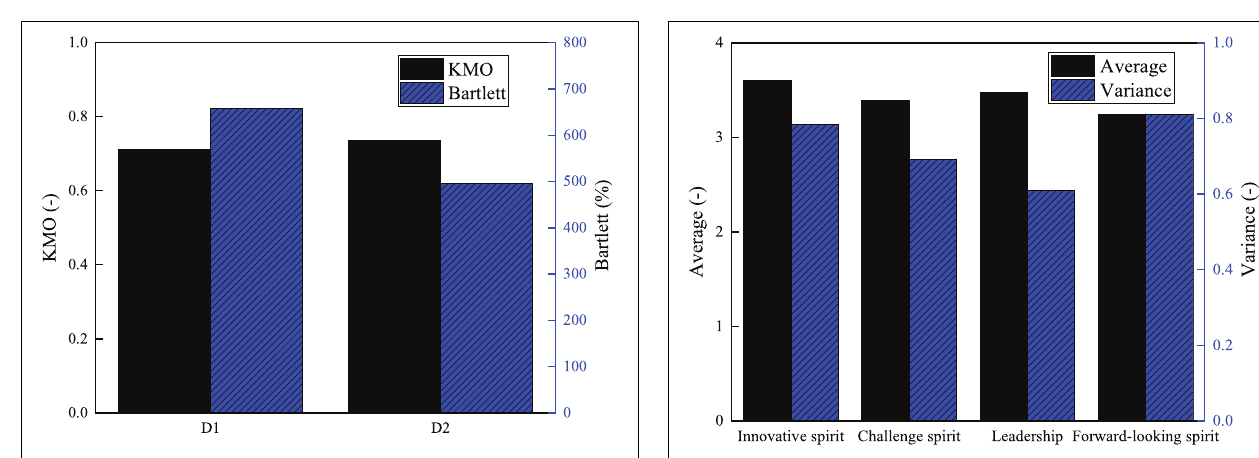
FIGURE 5 | The score of each dimension of the research